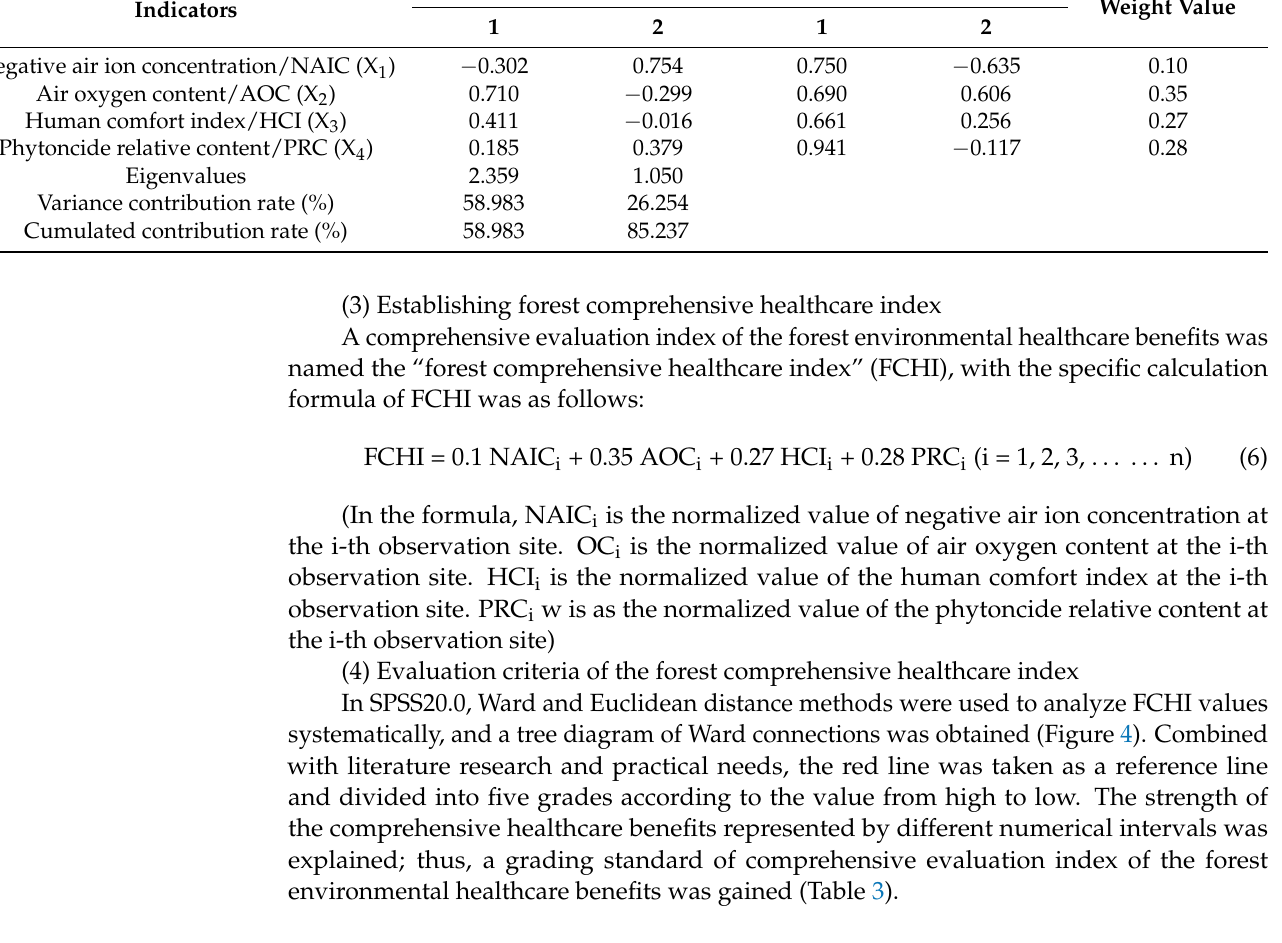
Table 3. Criteria for the forest comprehensive healthcare index (FCHI)